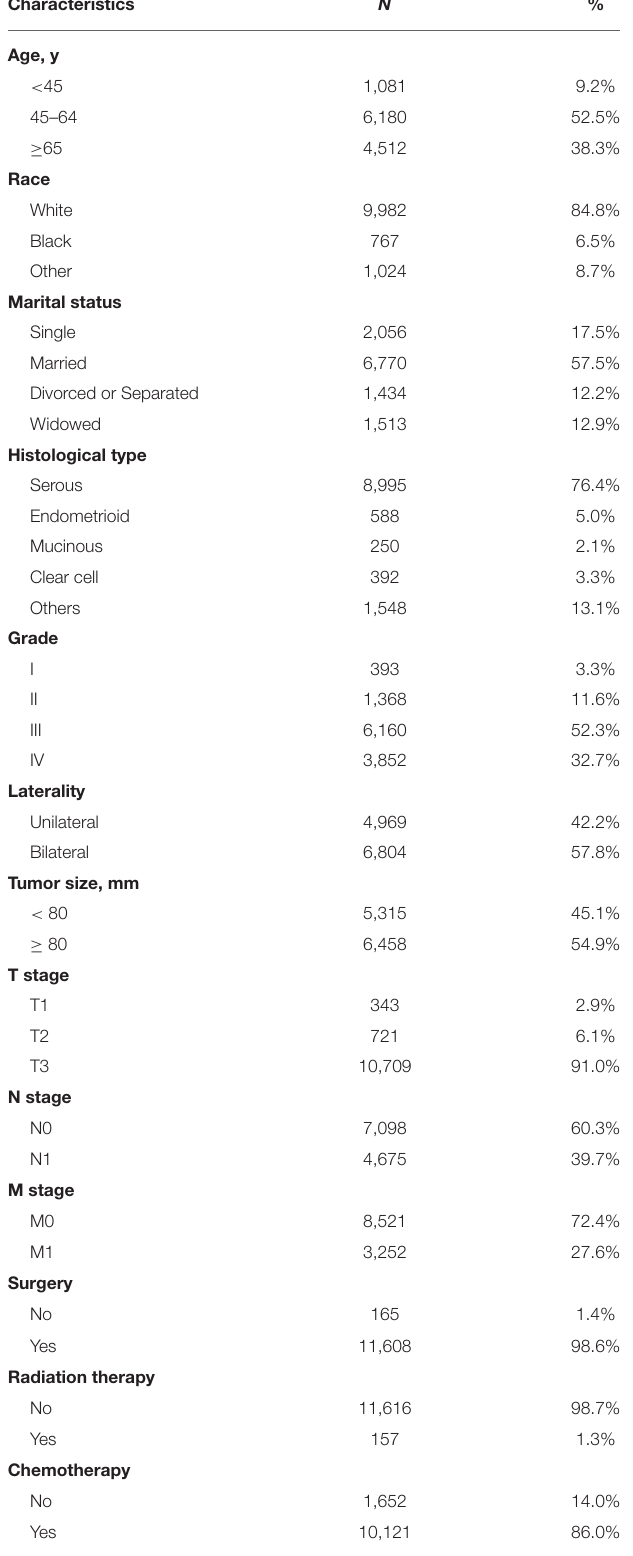
TABLE 1 | Baseline clinicopathologic